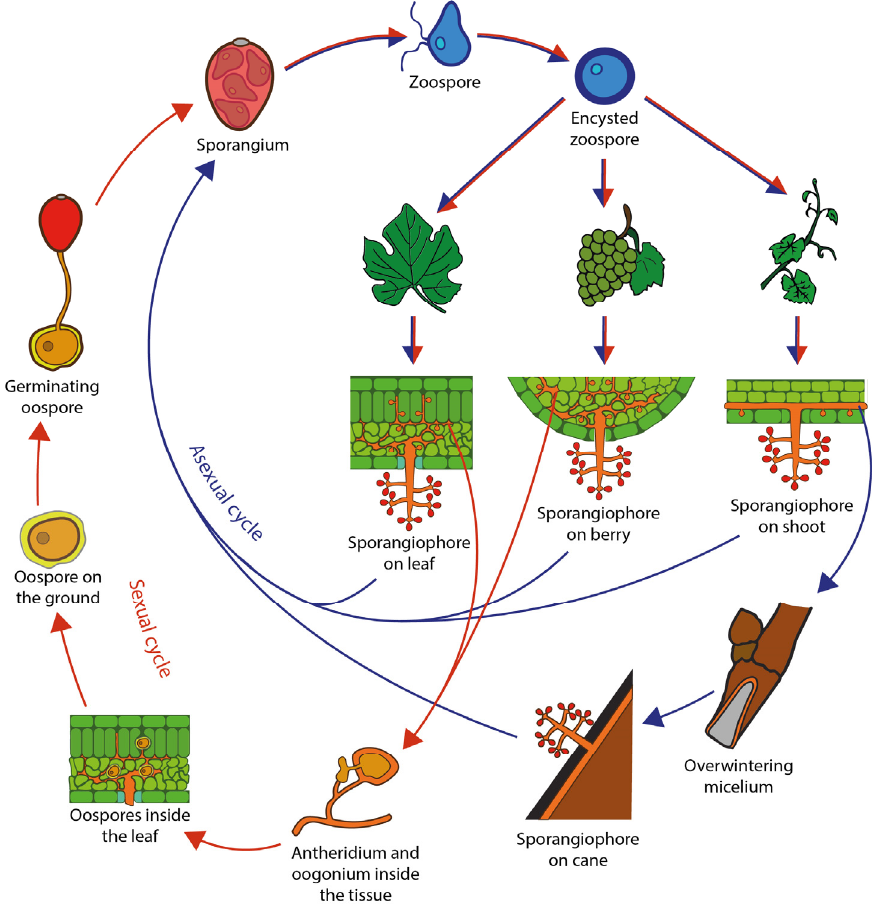
Figure 1. Schematic diagram of the disease cycle of downy mildew caused by Plasmopara viticola . Red arrows refer to the sexual cycle. Blue arrows refer to the asexual cycle.